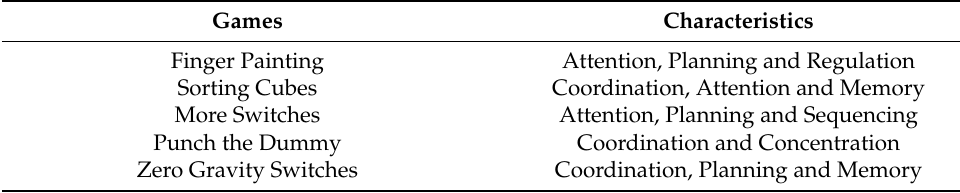
Table 2. Selected games from the software Hand Physics